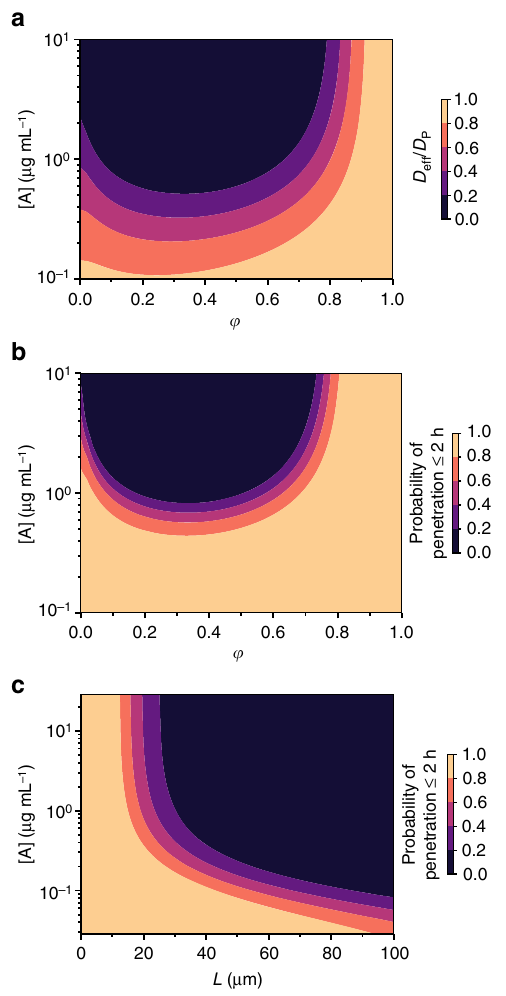
Fig. 4 Maximizing trapping by varying matrix thickness and anchor concentration. Heat maps of the a effective diffusivity and b , c probability of penetration of a gel layer within 2 h as a function of different fraction of free anchors ( a , b ) and thickness of matrix layer ( c ). Parameter values used were as follows: a D A / D P = 20 and N = 20; b D A / D P = 20, N = 20, and L = 50 μ m; and c D D = 20, N = 20, and φ ¼ 0 : A / P